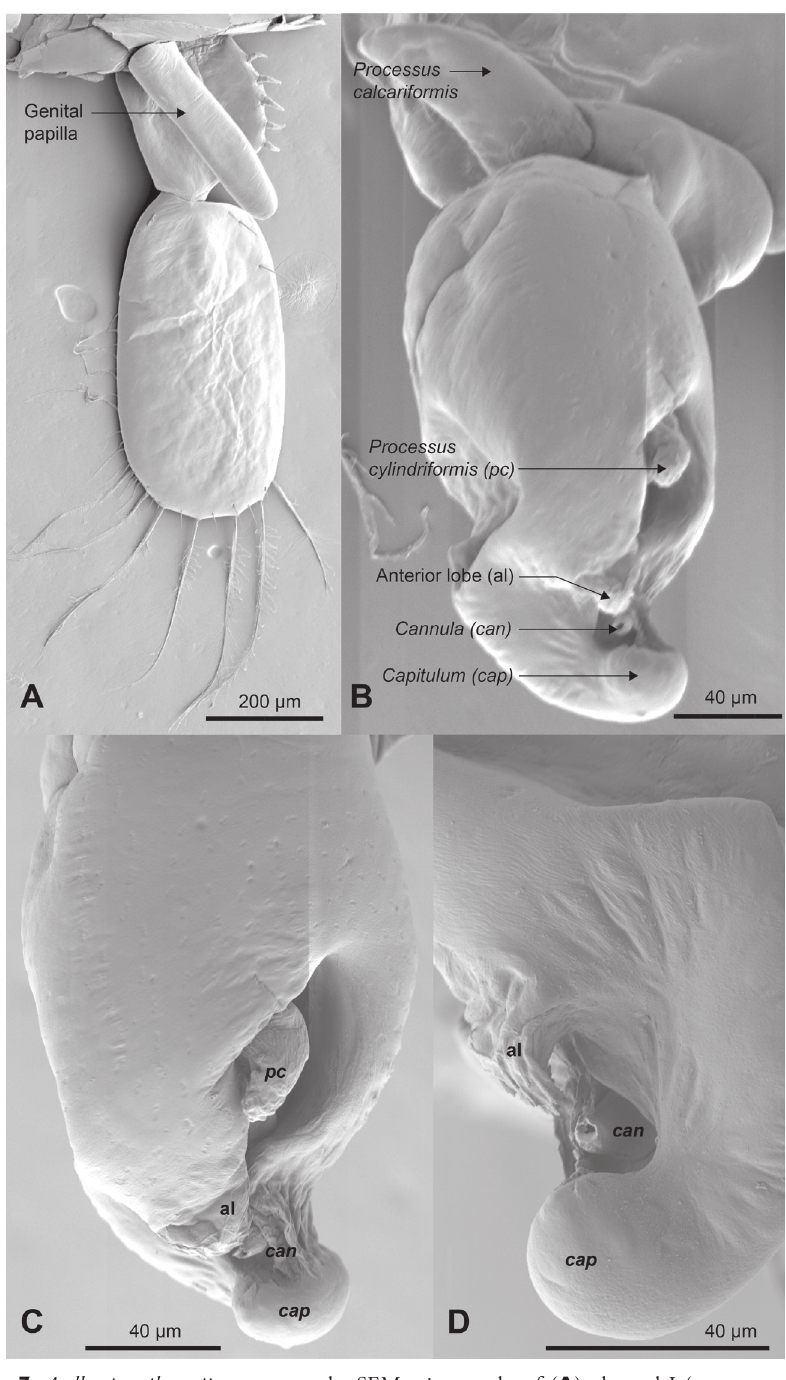
Figure 7. Asellus ismailsezarii sp. nov., male; SEM micrographs of ( A ) pleopod I (paratype male BL 8.2 mm: TU-SP.2). Photo also shows one genital papilla inserted on ventral side of pereionite VIII B, C, D pleopod II endopod (holotype male BL 8.2 mm: TU-SP.1) B, C ventral view and D lateral